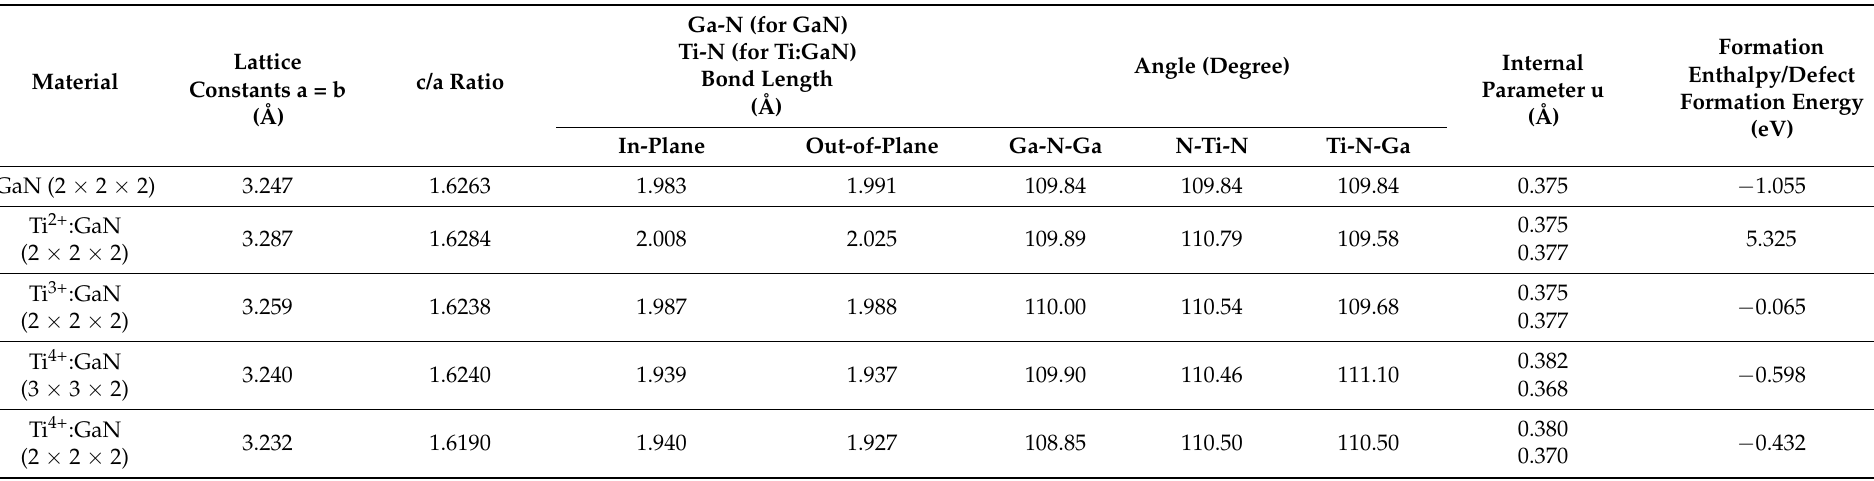
Table 3. The values of structural parameters and formation energy calculated for pure GaN, Ti:GaN with dopant charge states Ti 2+ , Ti 3+ , and Ti 4+